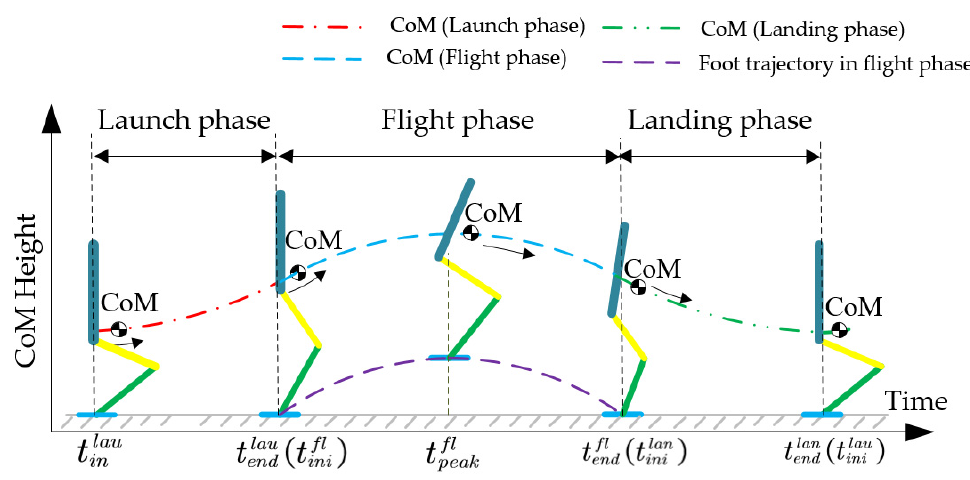
Figure 3. Time sequence of the vertical jumping motion.